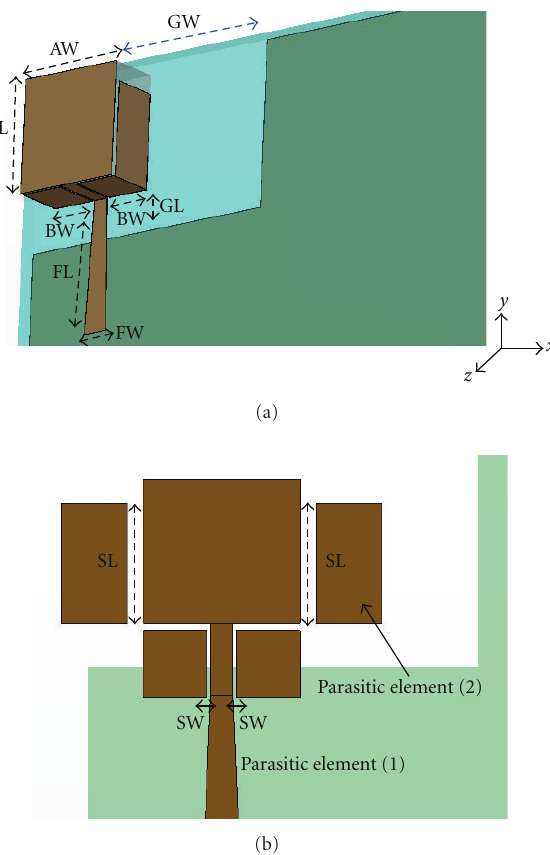
Figure 1: Configuration of the proposed antenna. (a) Designed structure, (b) planar figure.